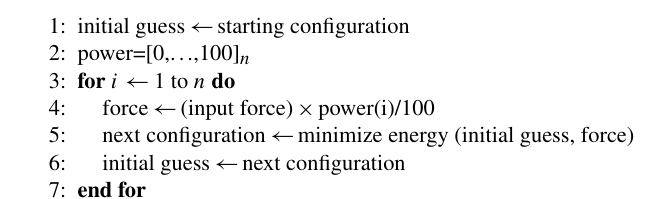
Algorithm 1 Algorithm for incrementally increasing